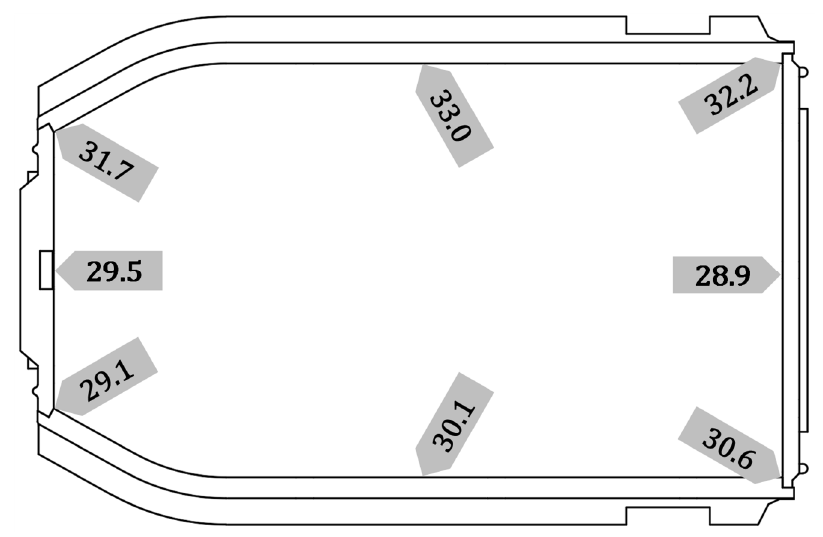
Figure 23. Stress distribution [unit: MPa].